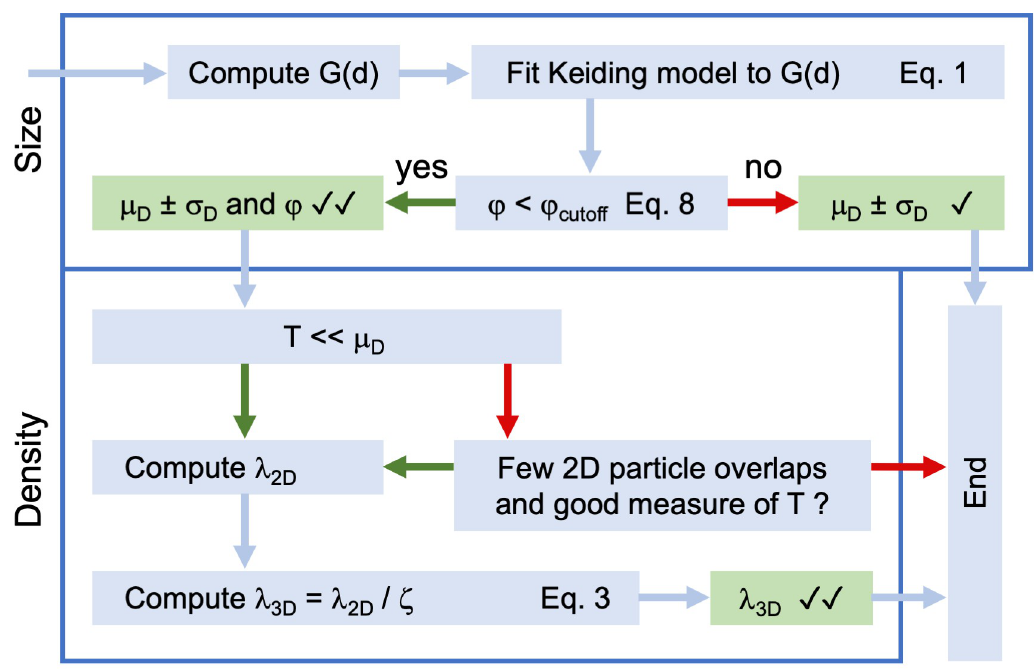
Fig 13. Methods workflow for estimating the 3D size and density of spherical particles from their 2D projection. Workflow diagram describing the sequence of steps for estimating F(d) ( μ D ± σ D ) and ϕ from G(d), and λ 3D from λ 2D , where G(d) and λ 2D are computed from a 2D projection of randomly distributed particles in a section of thickness T. Two check marks indicate a negligible bias and small confidence interval compared to one check mark. Final estimates of λ 3D can be converted to VF using estimated μ D ± σ D (Eq 4) and compared to that computed via the relation VF = K v � AF (Eq 14). Estimated ϕ is compared to estimated ϕ cutoff , computed via fit parameters μ D and σ D (Eq 9). Green and red arrows denote ‘yes’ and ‘no’ of conditional statements.